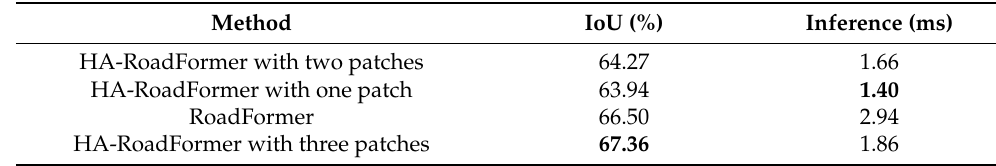
Table 2. Quantitative analysis results in different patch embedding combinations and attention